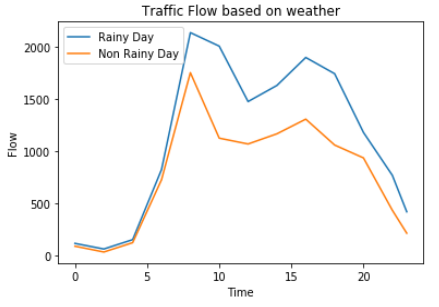
Figure 8. Traffic flow based on weather.